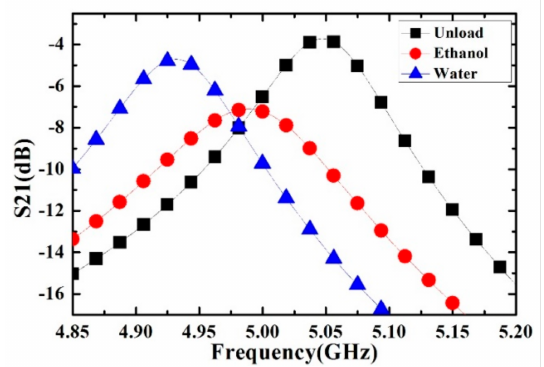
Figure 7. Measured transmission response of the microwave sensor. The curves represent different measurement conditions: the sensor with empty channel (unload), the sensor with channel filled with 100% ethanol, and 100% deionized